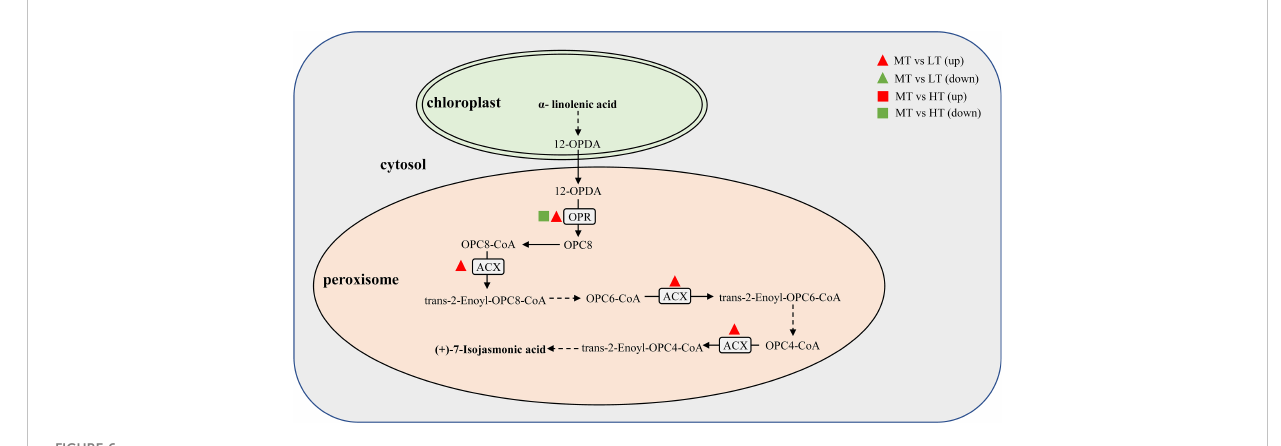
FIGURE 6 Pathways of the alpha-linolenic acid metabolism. The solid and dashed arrows indicate one-step and multi-step processes, respectively. The detailed descriptions of the DEGs are included in Supplementary Table